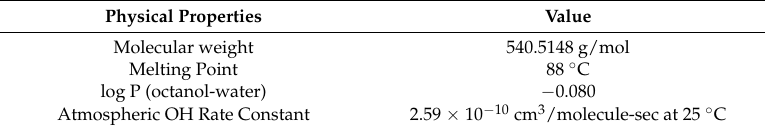
Table 1. Various physical properties of oleuropein (CAS 32619-42-4) [19].